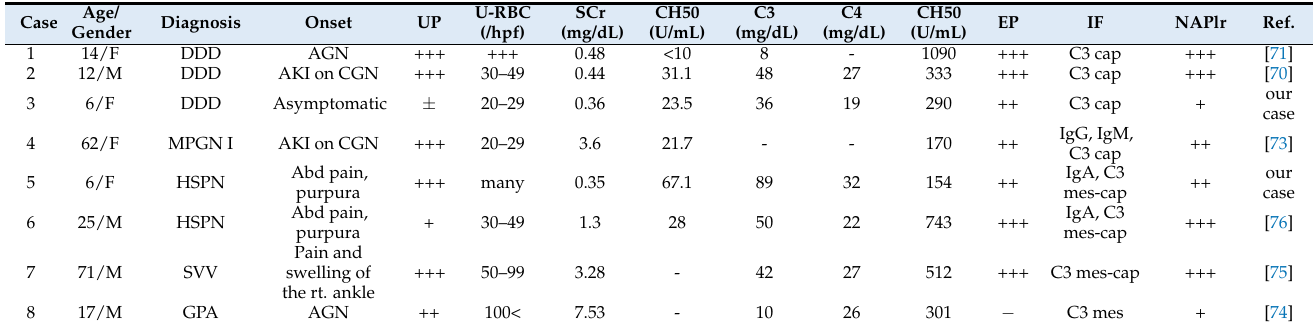
Table 5. Clinical and pathological profiles of patients with